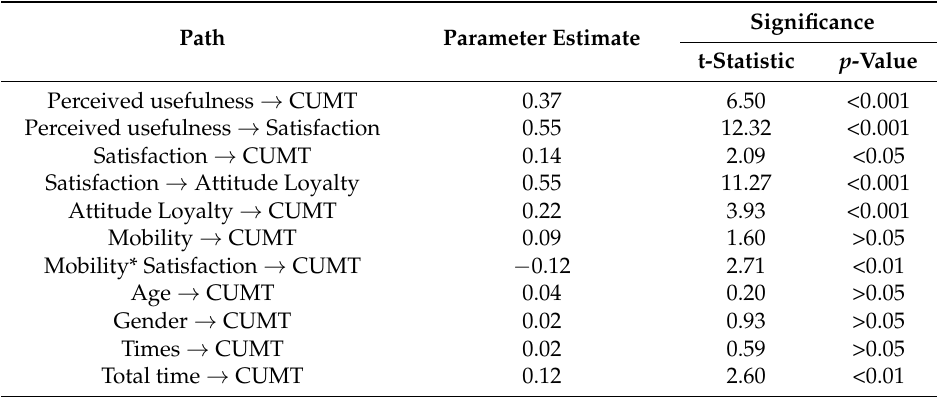
Figure 3. Full model of CUMT. Table 8. PLS results for the full model.